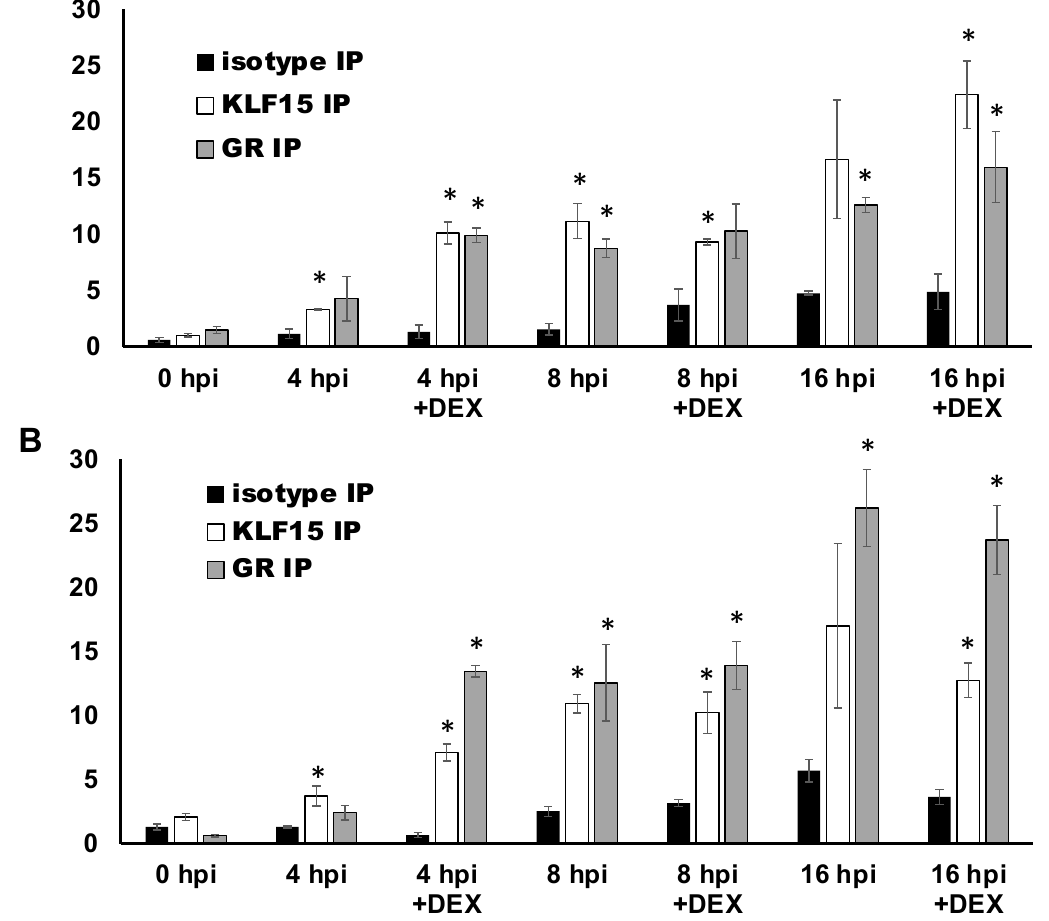
Figure 8. GR and KLF15 occupancy of the ICP27 promoter changes during productive infection. Neuro-2A (Panel ( A )) or Vero cells (Panel ( B )) were infected with HSV-1 (McKrae strain) at an MOI of 1 and then cultured in MEM containing 2% stripped FBS. Certain samples were treated with DEX (10 µM). At the indicated times after infection (0, 4, 8, and 16 hpi), ChIP was performed. The 0 hpi timepoint sample was washed with PBS, crosslinked, and harvested following 1 h incubation. ChIP was performed by immunoprecipitation by GR (5 µ g) or KLF15 (5 µ g) antibodies and non-specific isotype IgG as a negative control. ICP27 promoter DNA was amplified by PCR using p α 27 pro +/– primers (Figure 1C), which generates a 191 nt PCR product. PCR products were quantified using Image Lab software. Enrichment of DNA by GR and KLF15 antibodies is presented as a percentage of the input sample (13.3% of total sample). Data shown are the means of 3 independent experiments, and error bars indicate the standard error. Asterisks ( * ) identify significant differences in DNA amplification between the specific antibody samples and isotype control, as determined by Student’s t-test ( p < 0.05).